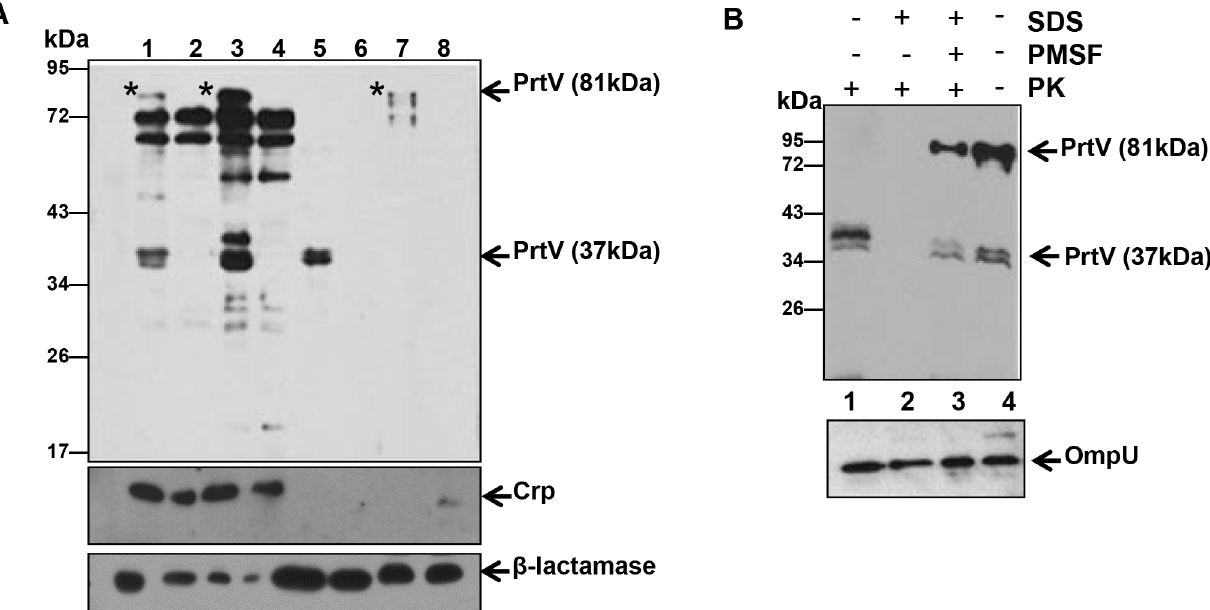
Fig 4. Immunoblot analysis of sub-cellular localization of PrtV protein in V . cholerae . (A) Immunoblot analyses of cell fractions from V . cholerae wild type strain C6706 (lanes 1, 3, 5, and 7) and the prtV mutant (lanes 2, 4, 6, and 8) using anti-PrtV serum (upper panel), anti-Crp antiserum (middle panel), and anti- β -lactamase antiserum (lower panel). Lanes 1 and 2: whole cell lysates; lanes 3 and 4, cytoplasmic fractions; lanes 5 and 6, periplasmic fractions; lanes 7 and 8, culture supernatants. Asterisks indicate the 81 kDa PrtV protein (B) Proteinase K susceptibility assay. OMVs from V . cholerae wild type strain C6706 were treated with 0.5 μ g ml -1 of proteinase K (PK), 1% SDS and/or the proteinase K inhibitor PMSF (1 mM) as indicated. Samples were examined by immunoblot analysis using polyclonal anti-PrtV antiserum (upper panel). Lane 1: OMVs treated with only PK; lane 2: OMVs treated with SDS and PK; lane 3: OMVs treated with SDS, PMSF, and PK; lane 4: control OMVs. The same membrane was re-probed with OmpU antiserum as an internal control (lower